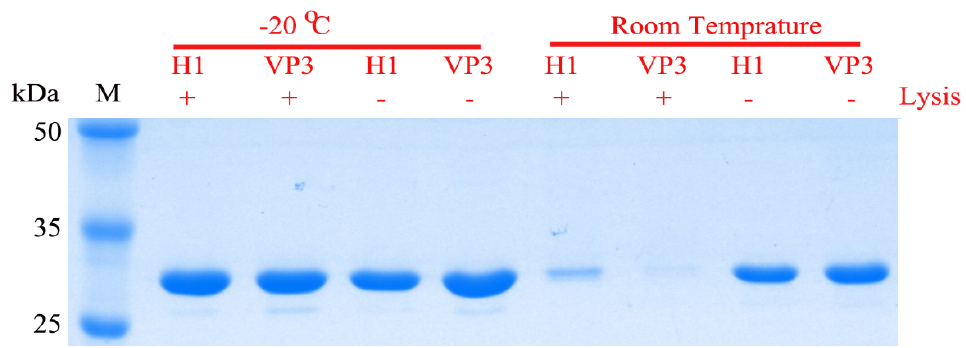
HRP-conjugated goat anti mouse IgG (1:20,000) was used as the secondary antibody.